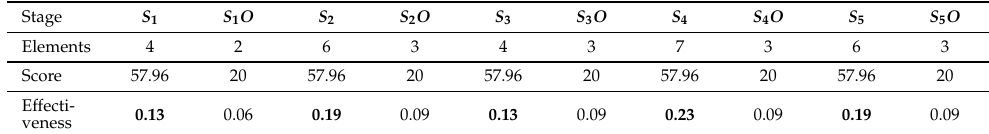
Table 7. Evaluation of the proposed method